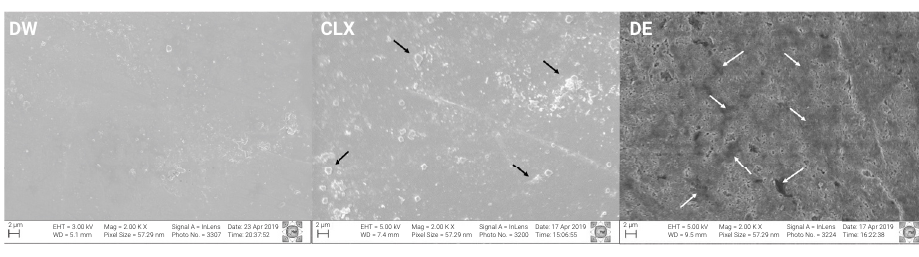
Figure 2. Scanning electron microscopy images of specimens exposed to distilled water (DW), 0.12% chlorhexidine digluconate (CLX), and Spondias mombin L . extract (DE). Mineral-like precipitation was observed in specimens exposed to CLX (arrows), while enamel dissolution was perceived in specimens exposed to DE